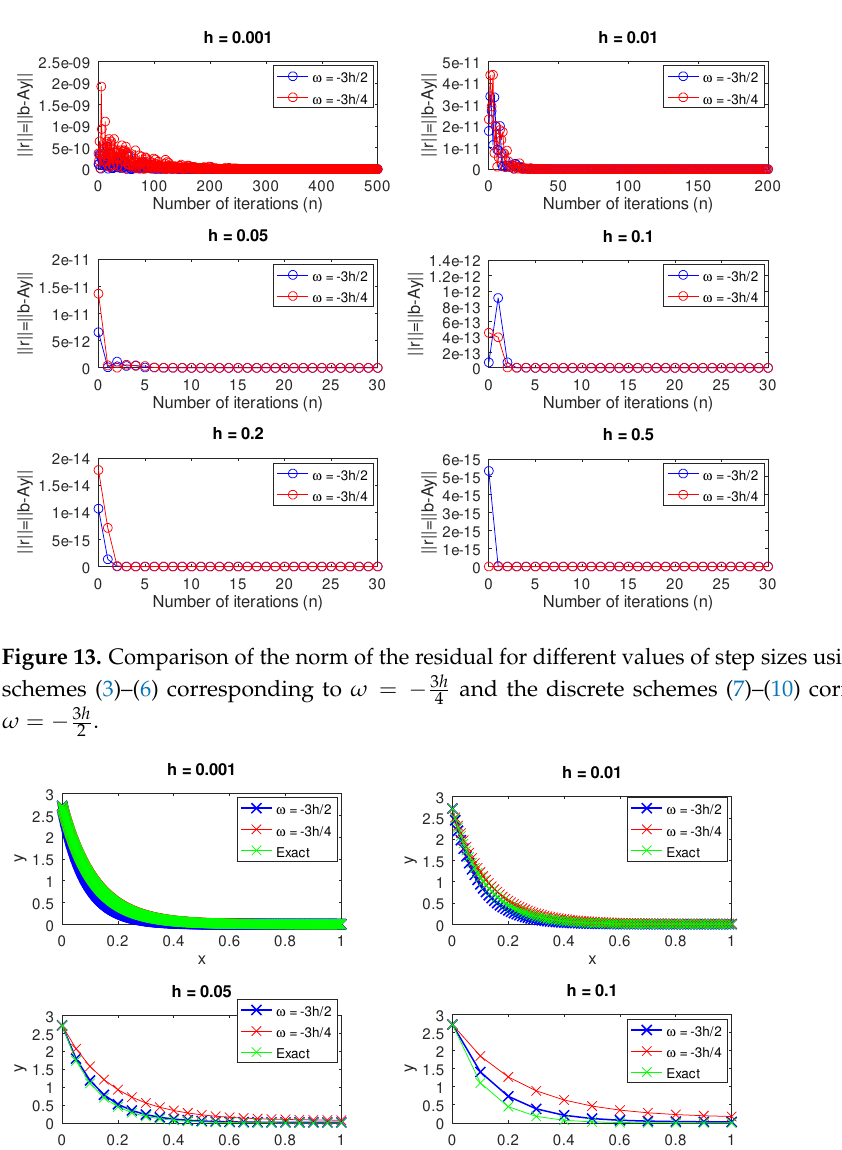
Figure 14. Comparison of the exact solution with those obtained from the discrete scheme (6) Figure 14. Comparing the exact solution with those obtained from the discrete scheme (6) corre- 3 h corresponding to ω = and the discrete scheme (10) corresponding to ω = 3 h 4 − sponding to ω = and the discrete scheme (10) corresponding to ω = 4 − ton’s Figure 13. Comparing the norm of the difference between the exact solution and the vector method. [ y n + 1 , y n + 2 ] T for different values of step sizes using the discrete schemes (11) corresponding to 3 h ω = and the discrete schemes (12) corresponding to ω = 4 − system of linear equations.